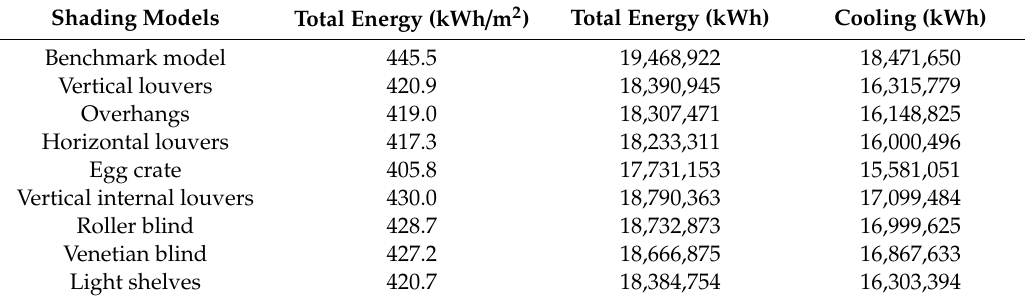
Table 9. Energy and cooling loads of di ff erent shading techniques.